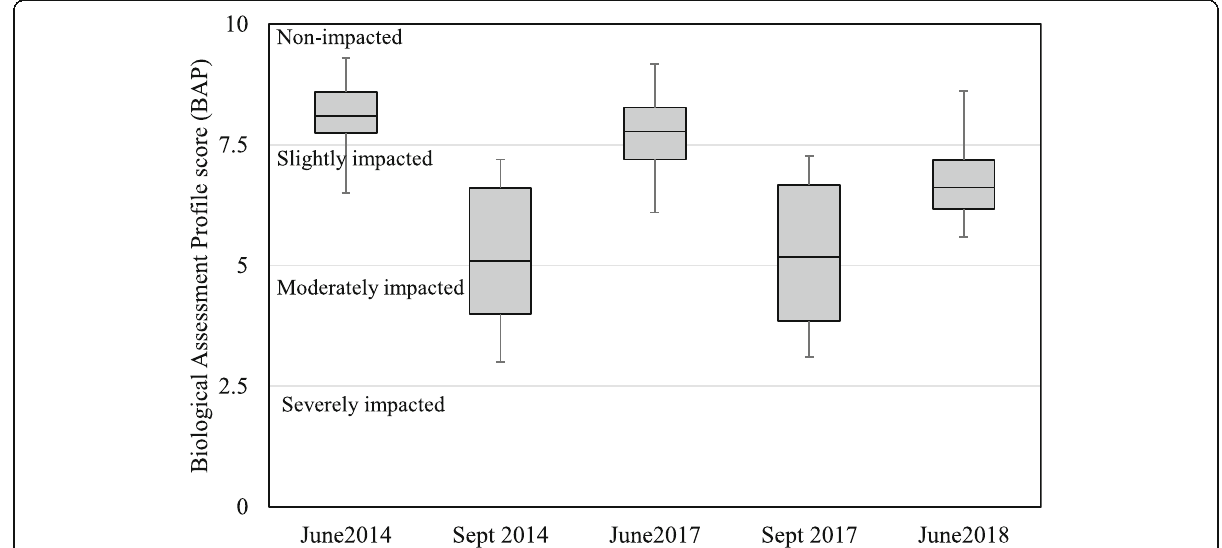
Fig. 4 Boxplots showing the median, 25th and 75th percentiles (shaded boxes), and outliers for the bioassessment profile (BAP) scores in all macroinvertebrate samples collected at seven sampling sites grouped by study month and